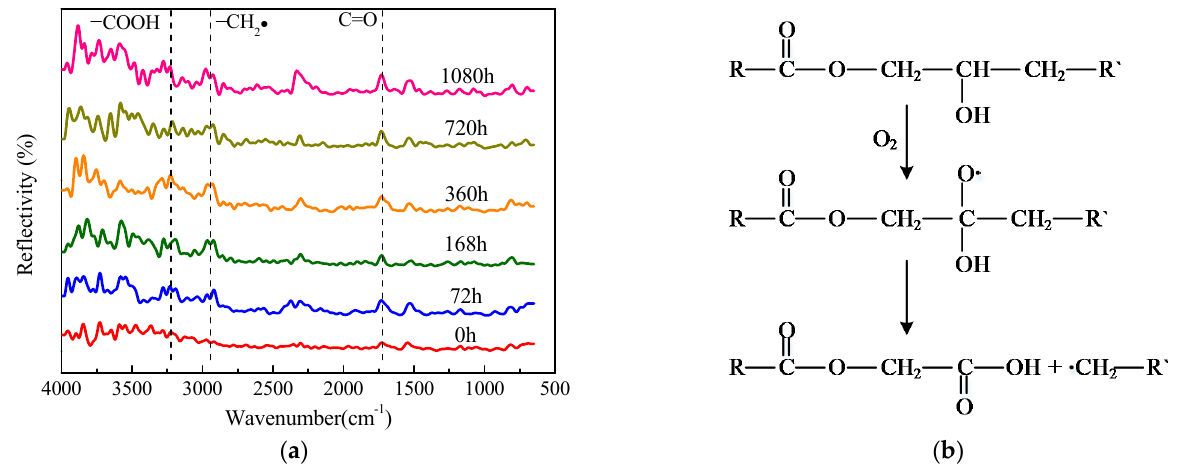
Figure 1. FTIR spectra and chemical decomposition of aged SiC/epoxy micro-composites: ( a ) Reflectance spectra of aged SiC/epoxy micro-composites; ( b ) Chemical decomposition of SiC/epoxy micro-composites caused by high temperature and oxygen.